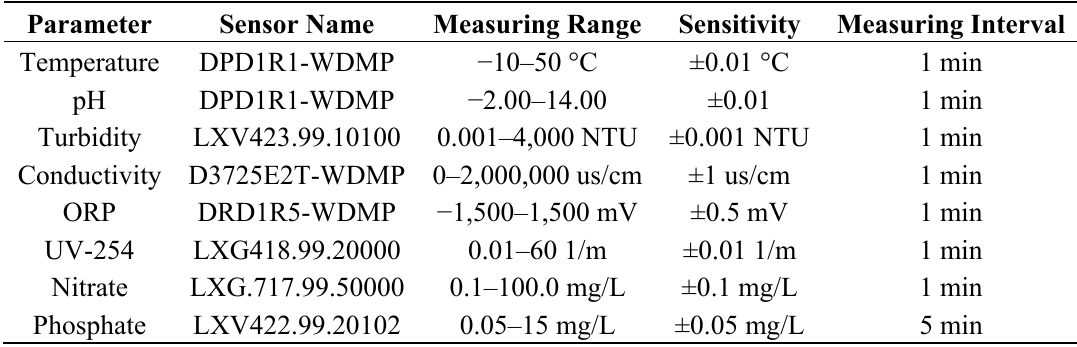
Table 1. Detailed information of the parameters and